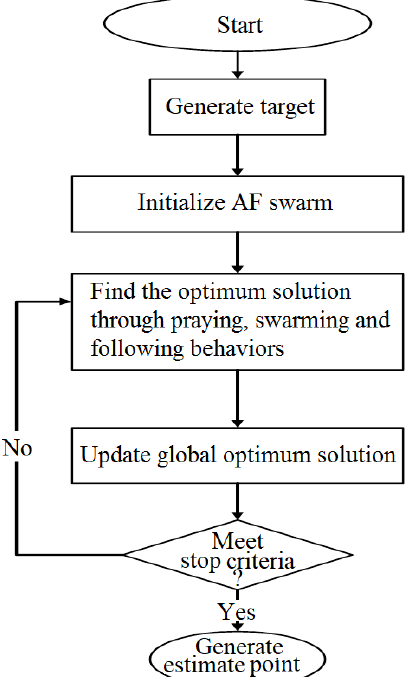
Figure 4. Flow chart of AFSA target positioning method.